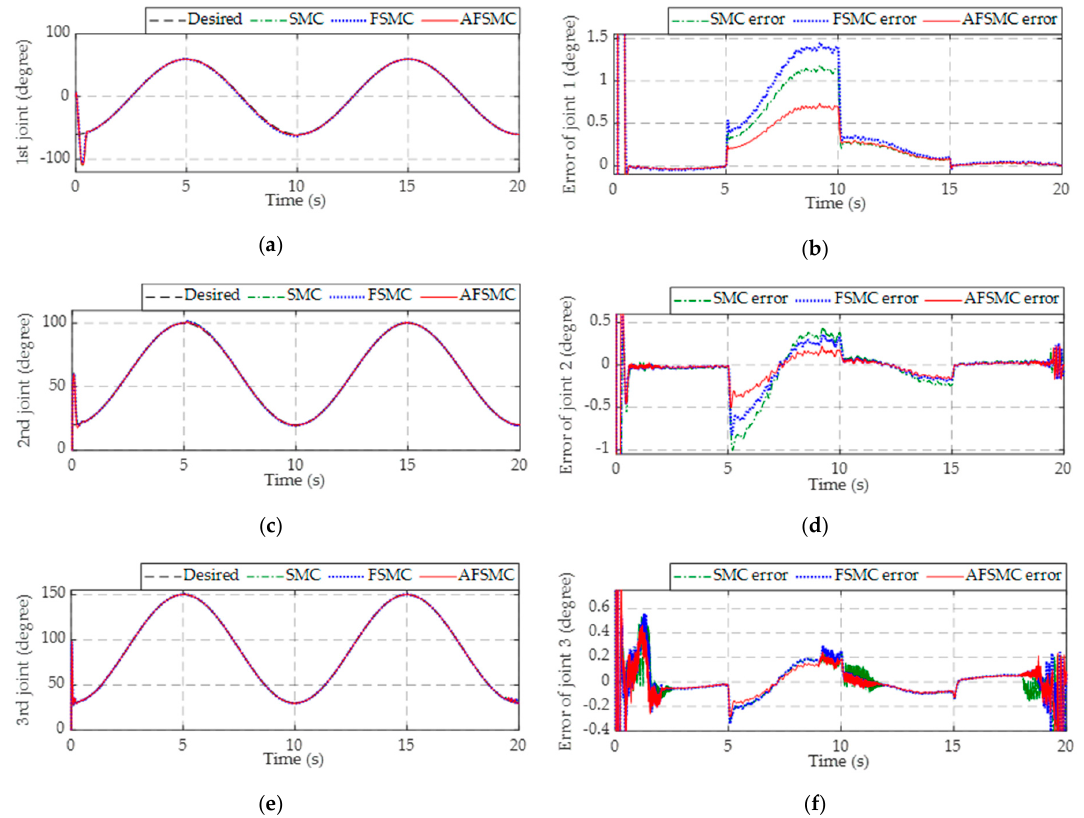
Figure 13. The tracking performance of the three joints: ( a ) The first joint and ( b ) its error; ( c ) the second joint and ( d ) its error; ( e ) the third joint and ( f ) its error in comparison between SMC and FSMC with AFSMC.